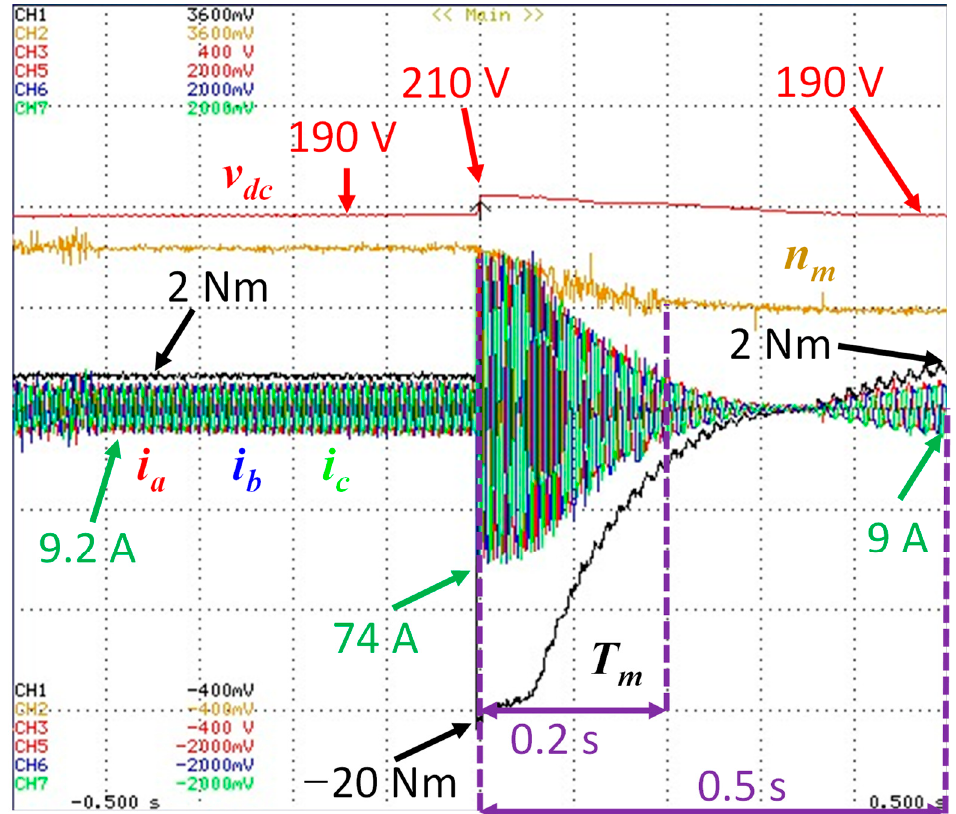
Figure 18. Experimental results of the traction system with a 2 Nm load decelerating from 1500 rpm to 1000 rpm: the torque ( T m ) and speed ( n m ) of the SRPM machine; dc-link voltage ( v dc ); stator windings’ currents ( i a , i b , i c ).